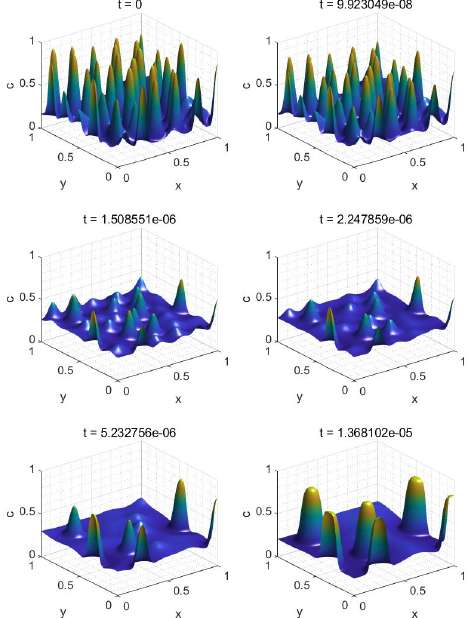
Figure 8. Dimensionless concentration spatial profiles c * ( x * , y * ) formed during the phase separation phenomena for the case where D = 10 5 , c o* = 0.3 and T * = 0.35. The asterisks were left out of the variables x , y , c , and t in the figure.